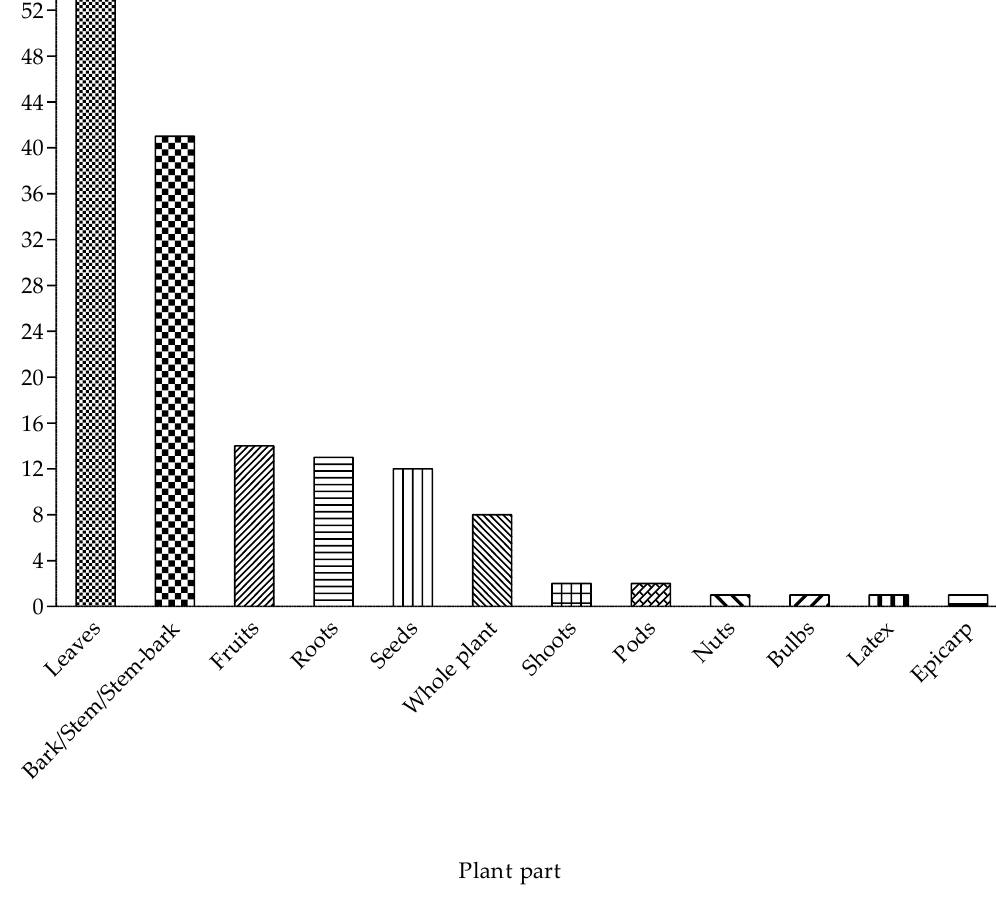
Figure 4. Plant parts used for managing cough associated with respiratory diseases in Ede South Local Government Area of Osun State, Nigeria.